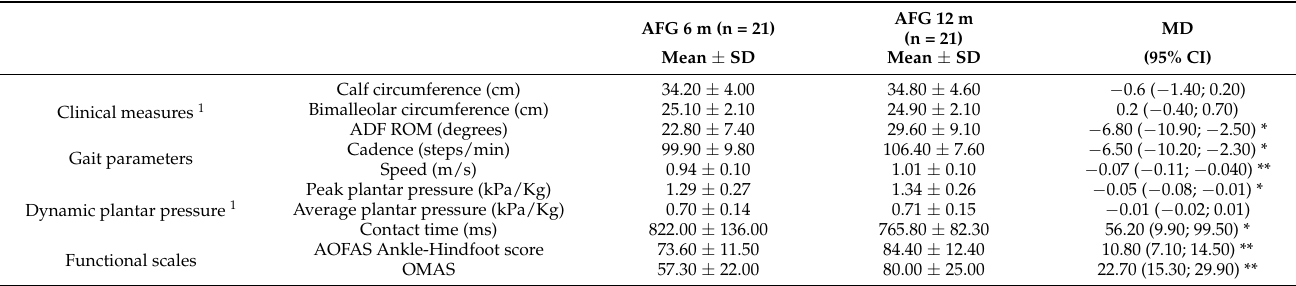
Table 6. Intra-group difference (AFG) at 6 and 12 months of clinical measures, gait parameters, dynamic plantar pressure, and functional scales.